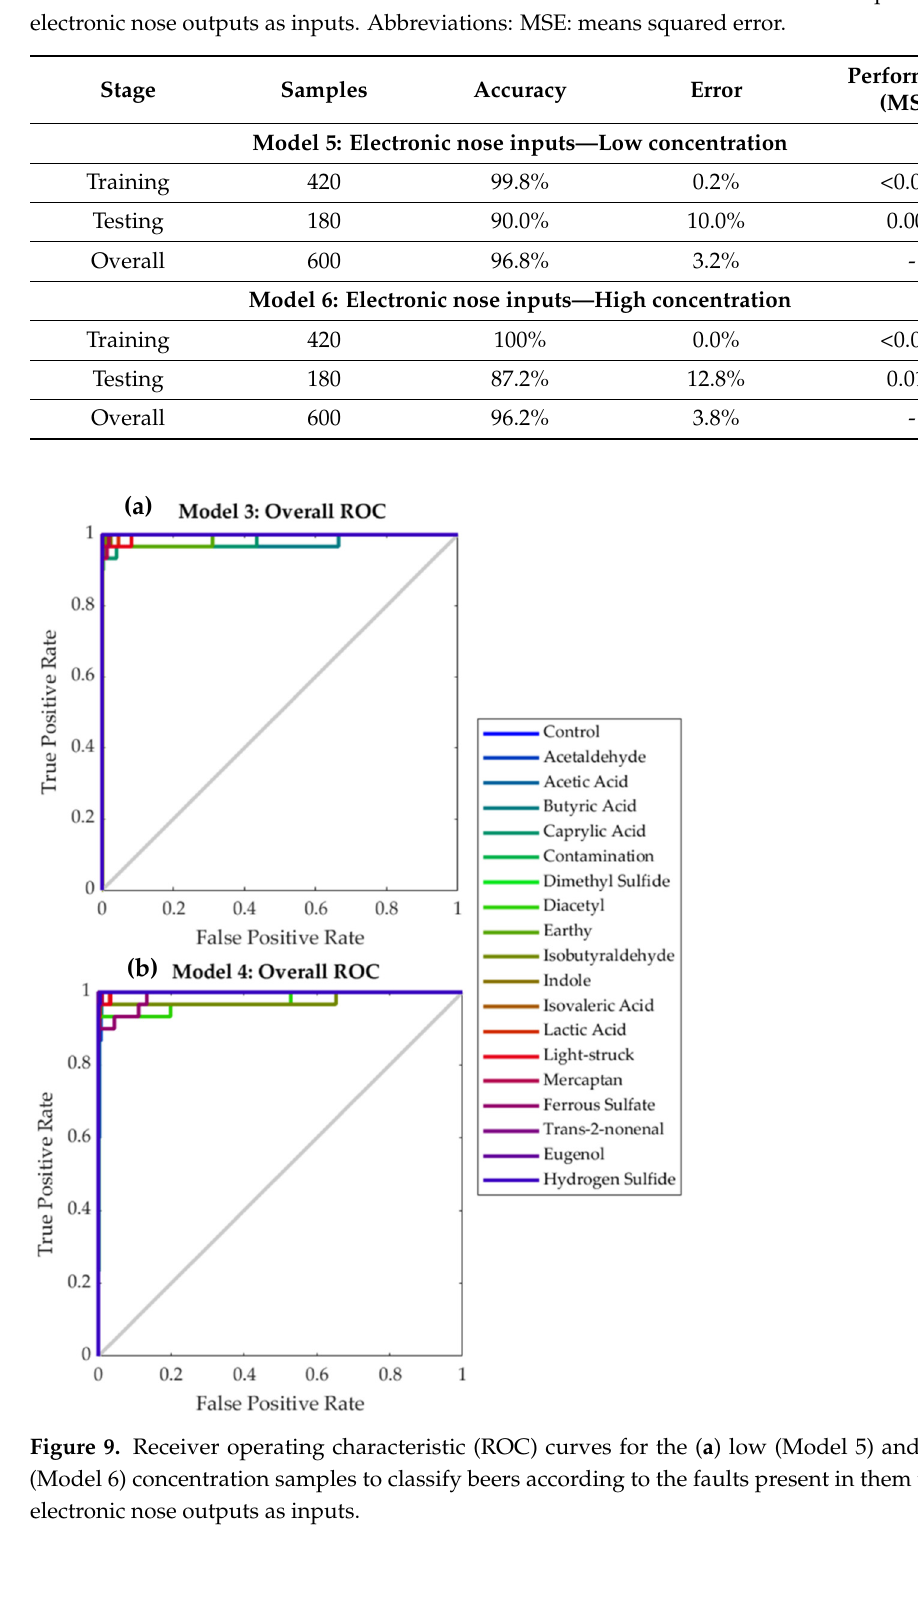
Figure 8. Receiver operating characteristic (ROC) curves of the ( a ) low (Model 3) and ( b ) high (Model 4) concentration samples to classify beers according to the faults present in them using the near-infrared absorbance values as inputs.